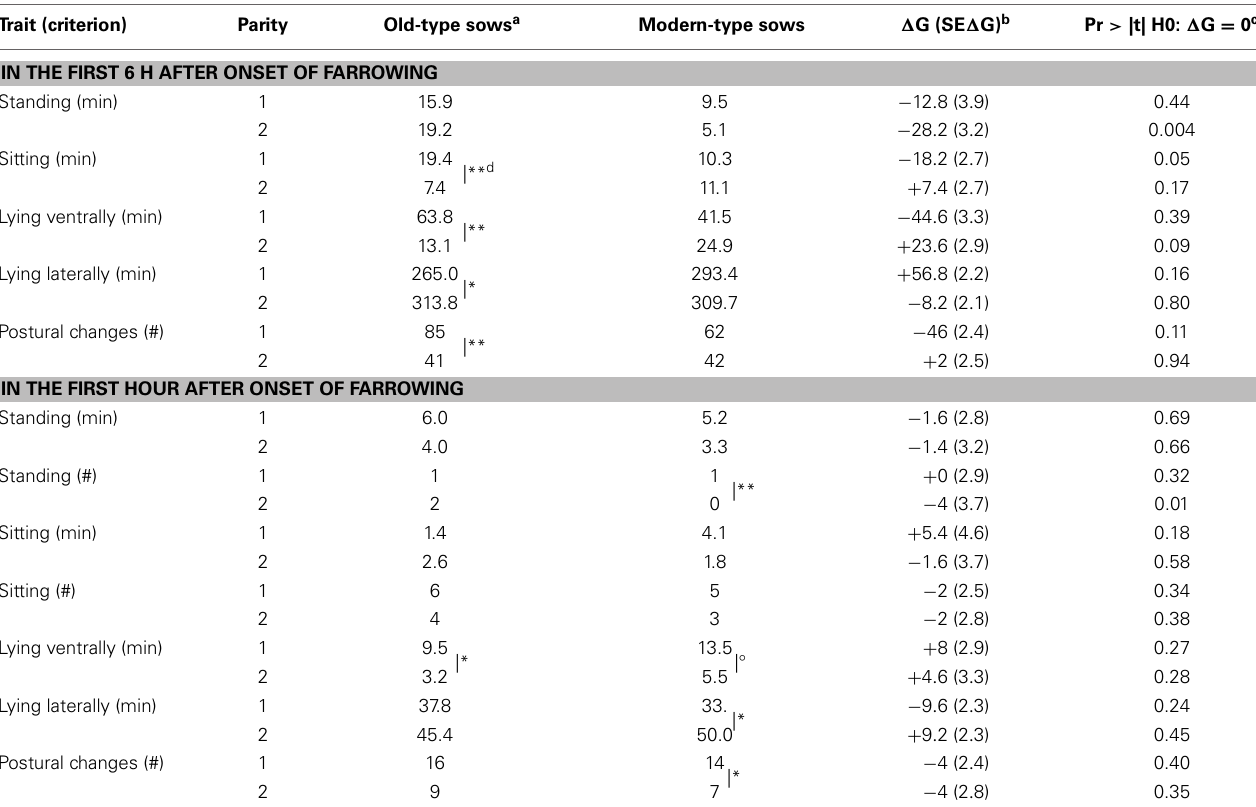
Table 3 | Genetic trends for sow postural activity at farrowing. Trait (criterion)